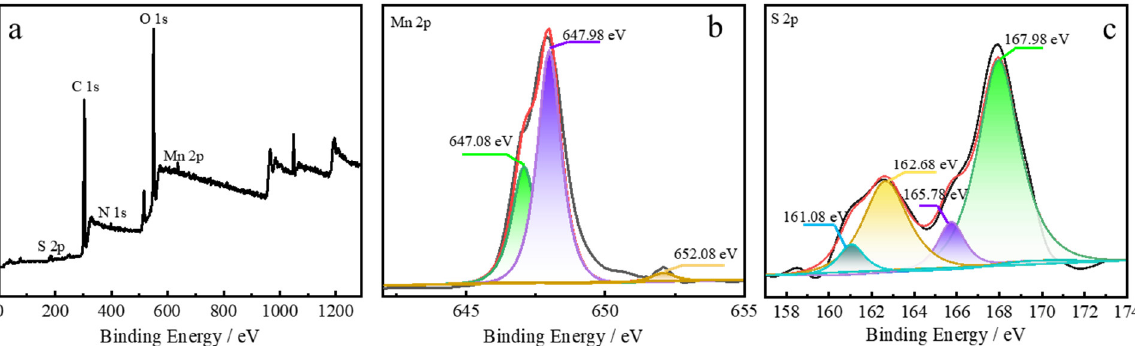
Figure 3. ( a ) XPS survey spectrum and ( b ) high-resolution Mn 2p, and ( c ) high-resolution S 2p XPS spectrum of SQDs@MnO 2 NS.